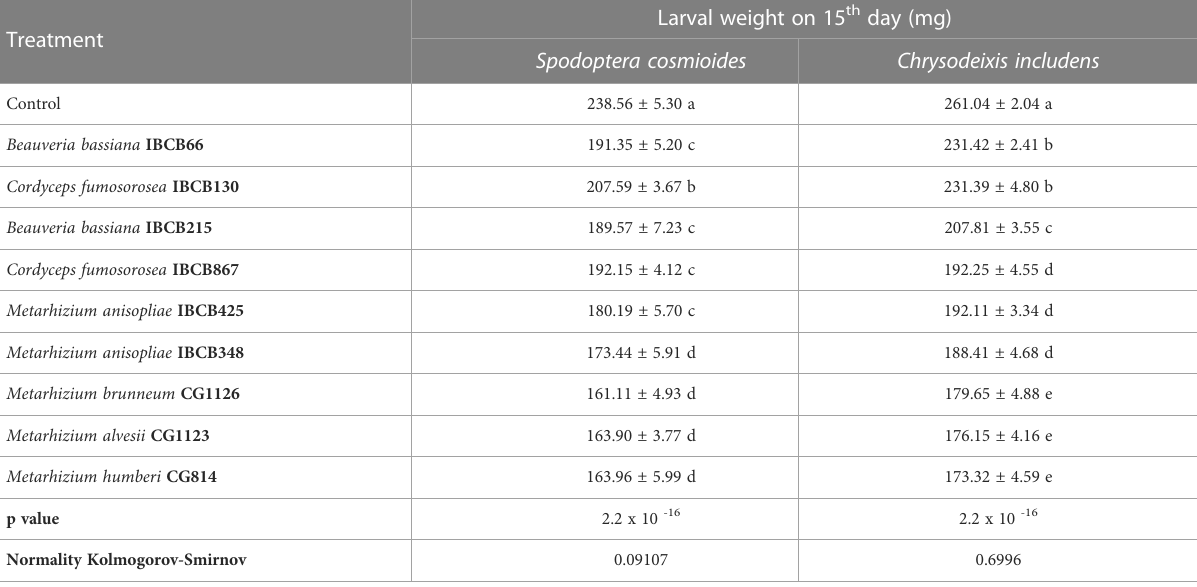
TABLE 2 S. cosmioides and C. includens larval weights after feeding for 15 days on peanut plants inoculated with entomopathogenic fungi and uninoculated control.